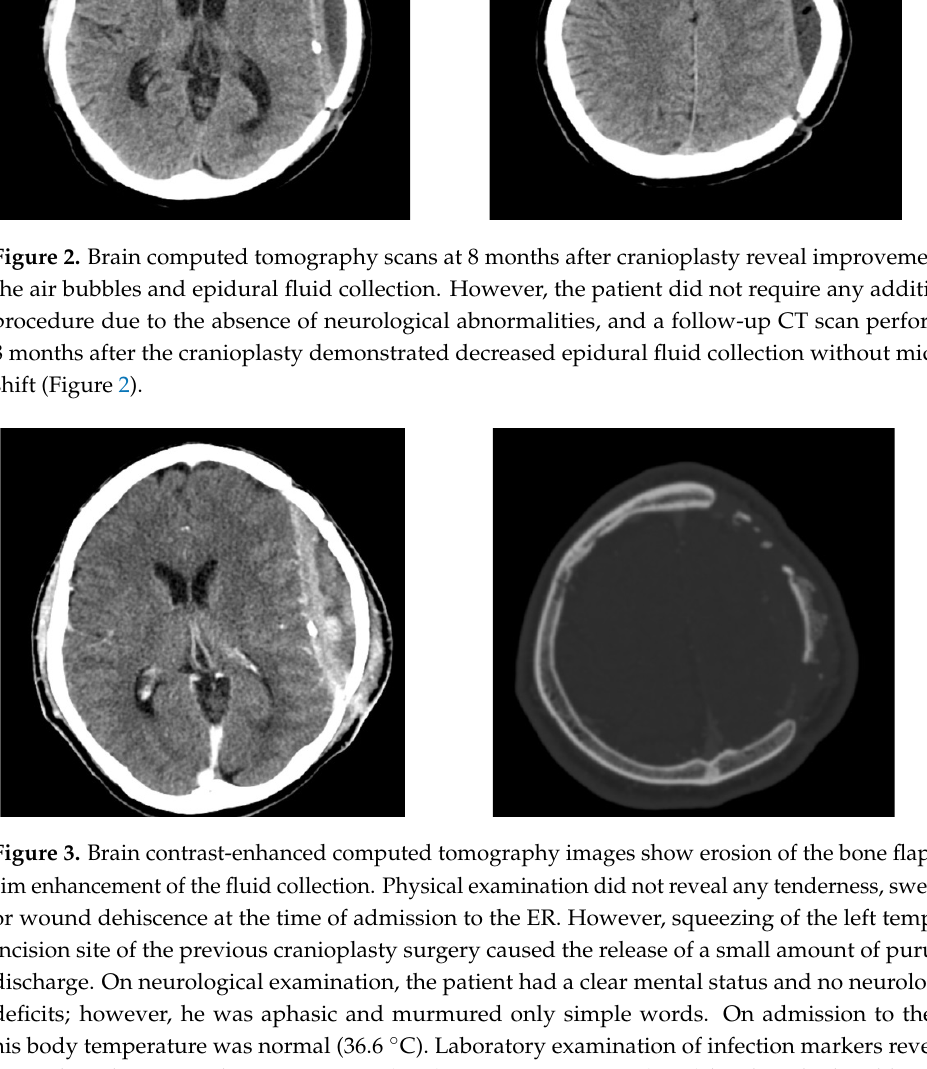
our knowledge, no studies have reported aphasia caused by delayed epidural abscess after cranio-